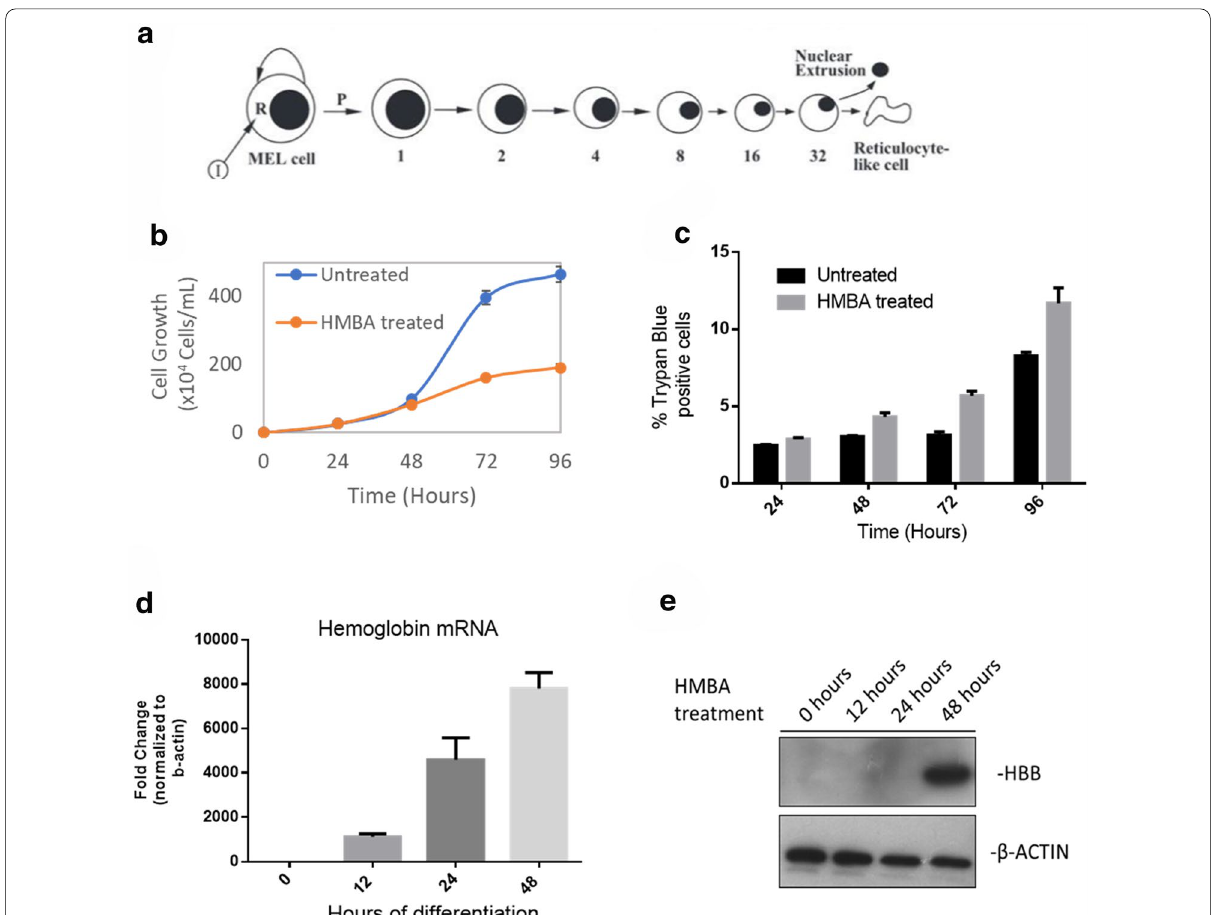
Fig. 1 Assessment of the proliferation and differentiation capacity of MEL cells upon the induction of erythroid maturation in vitro. a Schematic overview of the MEL cell differentiation program to erythroid maturation in vitro (modified from [17]). Upon exposure to chemical inducers (I), the cells initiate their differentiation program to erythroid maturation with a probability (P) through the activation of crucial intracellular molecules (R). For all experiments described in this study, HMBA was used as the chemical inducer of differentiation. Committed cells lose their proliferative potential and may only divide 4–5 times, while they decrease in size and enucleate, under certain conditions during the final stage of differentiation, resembling to erythrocytes. b Proliferation of MEL cells in culture treated with HMBA in comparison to untreated MEL. c Cell death in untreated vs treated with HMBA cells for the indicated time points, scored by trypan blue exclusion assay. d Cells were induced to differentiate by treatment with HMBA and total RNA was isolated. qPCR analysis of the β-globin mRNA at the indicated time-points reveals efficient induction of differentiation. e Same experiment with D, although, here, total protein material was isolated and followed by Western blot analysis of the β-globin protein at the indicated time